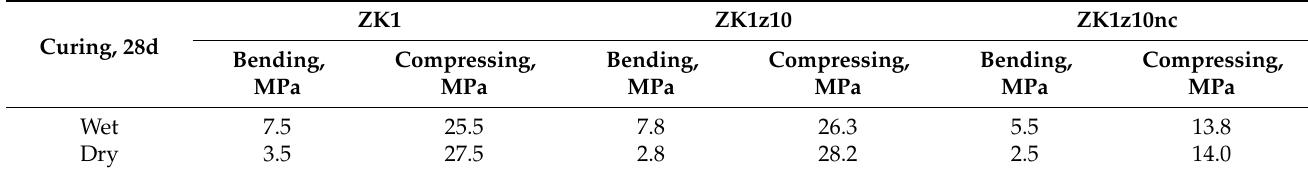
Table 8. Strength of binders after 4 weeks of hydration in wet and dry conditions.